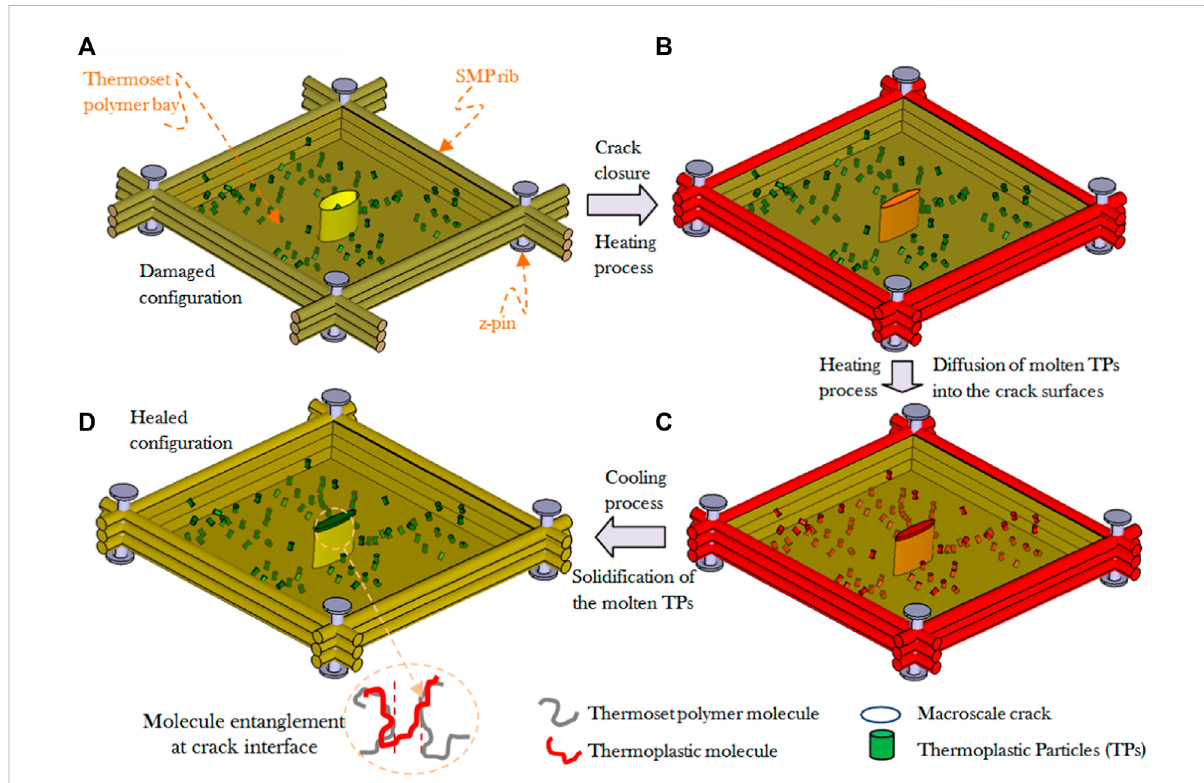
FIGURE 6 Bio-inspired healing composite structure consists of the SMP fi ber grid. (A) Unit cell of the SMP grid (ribs and z-pins) with a macroscopic crack (T < T g ), (B) crackclosureprocess(T > T g ), (C) thermoplasticparticlemeltingprocess(T > T m ),and (D) coolingdownprocess(T < T g ).Formoredetails, refer to Liand Shojaei, 2012[Reproduced withpermission fromProceedingsof theRoyalSocietyA: Mathematical,Physical and